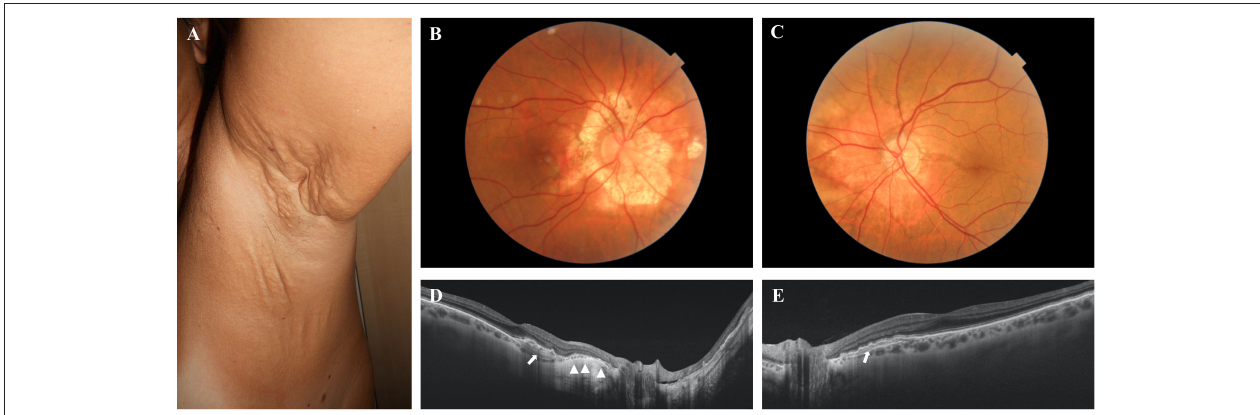
FIGURE 1 | (A) Skin plaques and skin laxity in the axillary area. (B,C) Colour fundus photographs of the posterior pole of the right and left eye, respectively. A large peripapillary atrophic area (B) and angioid streak passing through the fovea (C) are evident. (D,E) Optical coherence tomography examinations of the right and left eye, respectively. The atrophy of the retinal pigment epithelium (RPE) is evident in the right eye (arrowheads). Arrows show the abnormalities of the RPE–Bruch’s membrane complex.